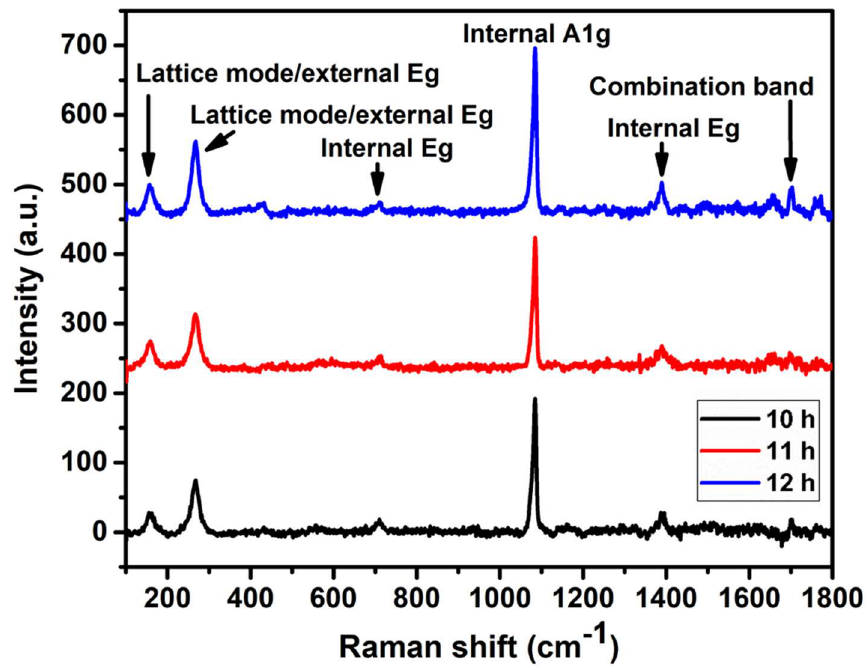
Figure 2. Raman spectra of the CdCO 3 samples deposited at 10, 11 and 12 h.